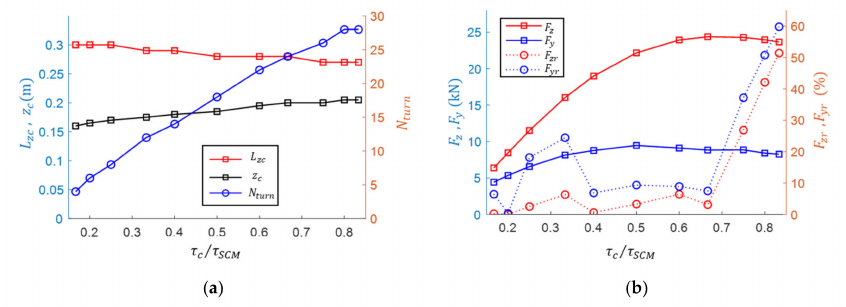
Figure 14. Comparing the shape and performance of the design that maximizes lift for the velocity v h with the change in the pole pitch; Comparative analysis of the ( a ) design variables, ( b ) lift and guidance force, and force